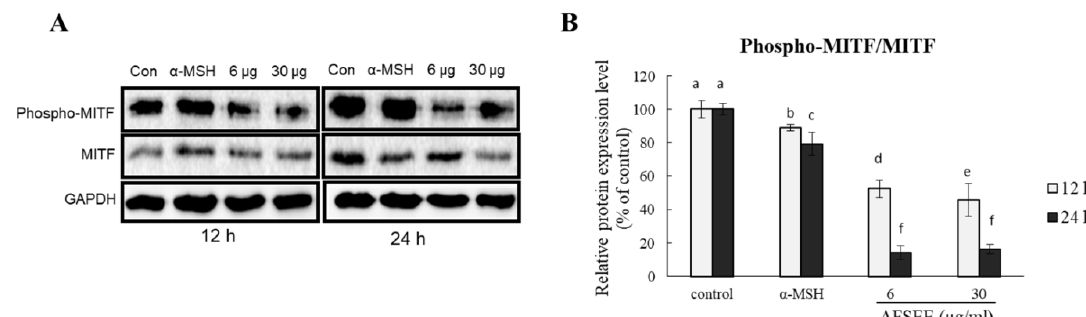
Figure 4. Effect of argan fruit shell ethanol extract (AFSEE) on the expression level of phosphorylated microphthalmia-associated transcription factor (pMITF) and total MITF. ( A ) The expression level of pMITF and MITF were determined by Western blotting. B16F10 cells were cultured in a 100 mm dish at a density of 3×10 5 cells/dish and treated without (control) or with α-MSH (200 mM) or AFSEE (6 µg/mL and 30 µg/mL) for 12 h and 24 h. ( B ) The protein band intensities of pMITF and MITF were obtained using Li-COR Software. Data were subjected to ANOVA ( n =3). All comparisons were made between treatments. Different letters indicate treatment differences at the p ≤ 0.05 level.